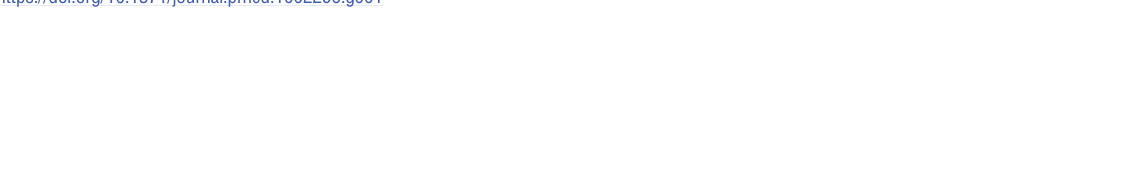
PLOS Medicine| https://doi.org/10.1371/journal.pmed.1002296 May 9,